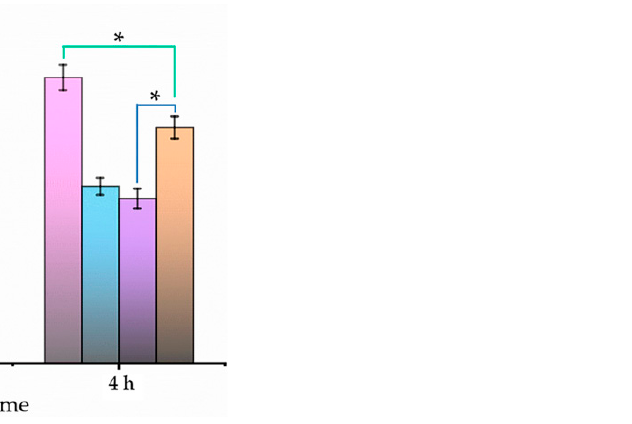
Figure 7. The intracellular Pt contents by treating with cisplatin, PPM, MTN, and MTN + MH for 1 h and 4 h. The MH was operated for the initial 20 min of the study. (* p < 0.05; ** p < 0.01).